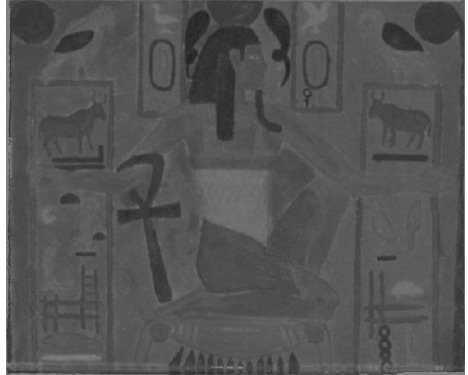
Figure 9. Point Cloud reflection intensity Image